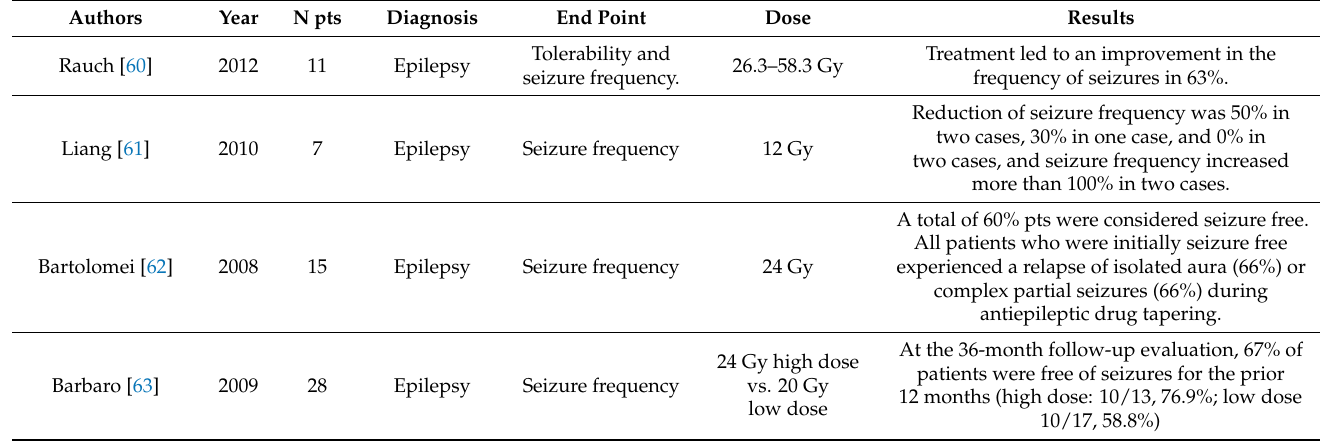
Table 4. Neurological disorders: included study and radiotherapy